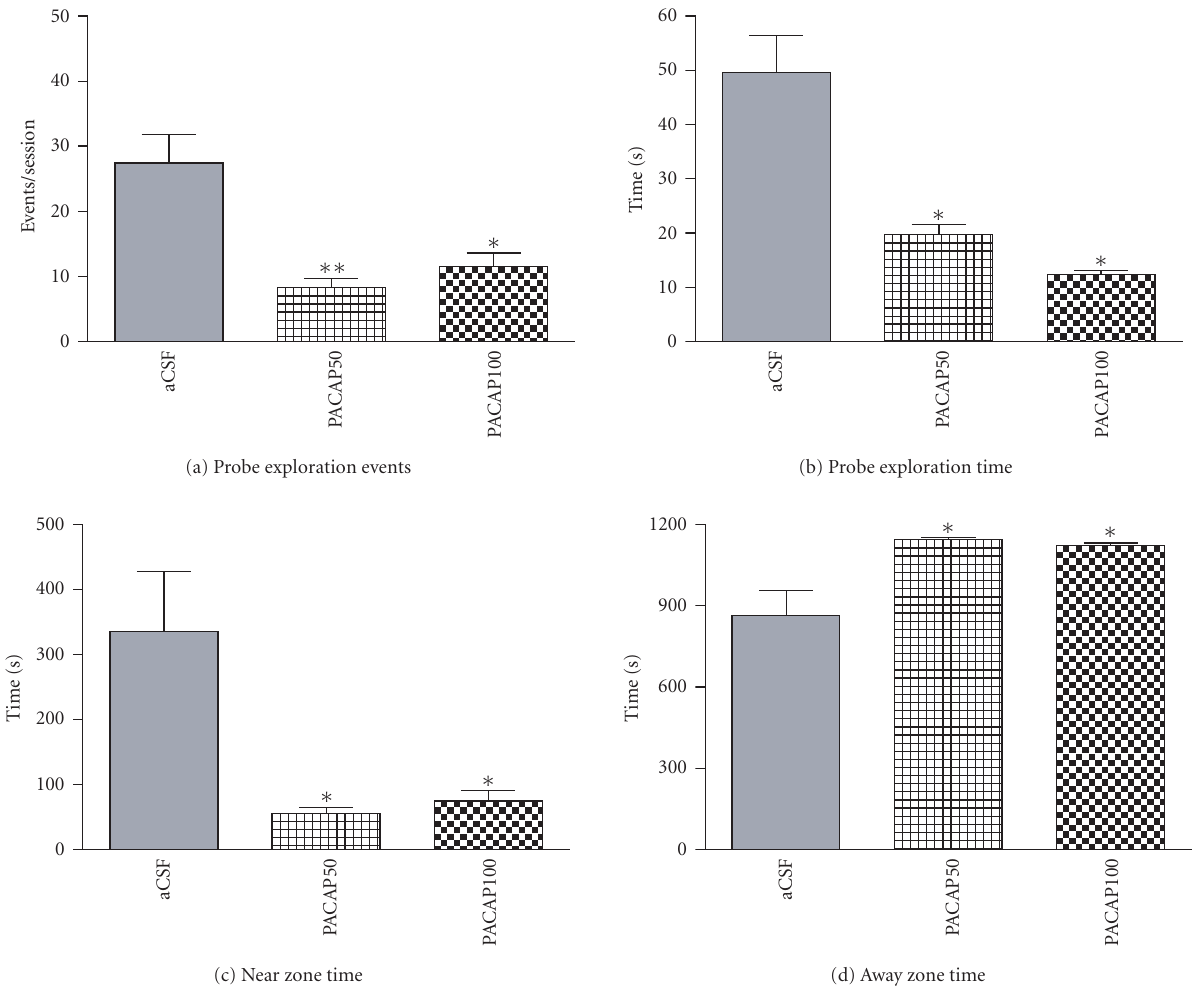
Figure 2: E ff ects of intra-CeA microinfusion of PACAP on shock-probe exploration and zonal preference in shocked rats. The numbers of probe exploration events (a) and time spent on probe exploration (b) are significantly reduced by intra-CeA PACAP. Zonal preference is altered by intra-CeA PACAP microinjection as rats spent significantly less time in the near zone (c) but more time in the zone away from the electrified shock probe (d). ∗ P < . 05 and ∗∗ P ≤ . 001 compared to aCSF controls. (aCSF n = 7/group, PACAP50 n = 7/group, PACAP100 n =